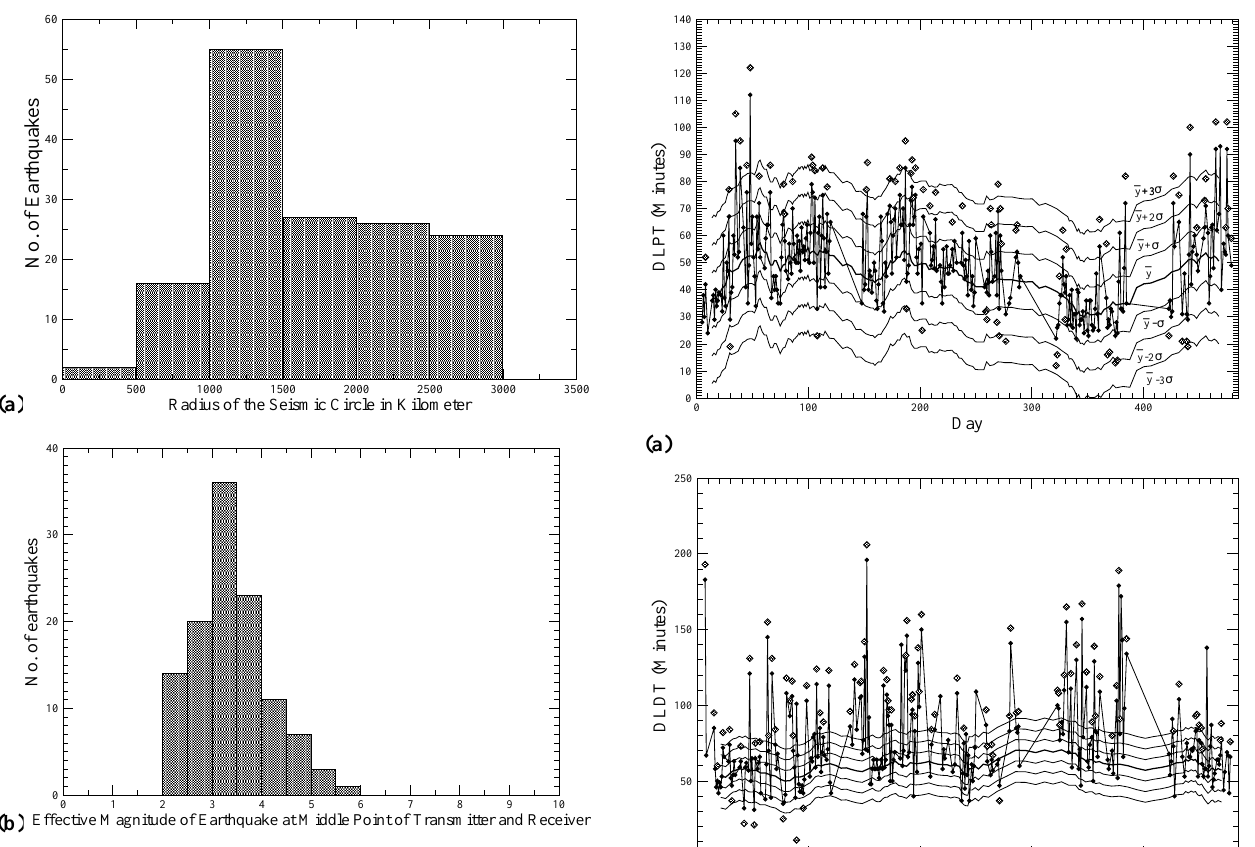
Fig. 2. Histograms of (a) total number of earthquakes in the seismic circles showing that the majority of the earthquakes hap- pened between 1000km and 1500km and (b) the effective mag- nitudes of earthquakes as seen from the FRP. The plot peaks at Fig. 2. (a-b): Histograms of (a) total number of earthquakes in the <M s > ∼ 3 − 3 . 5. seismic circles showing that the majority of the earthquakes hap- Fig. 2. (a-b): Histograms of (a) total number of earthquakes in the pened between 1000 km and 1500 km and (b) the effective mag- seismic circles showing that the majority of the earthquakes hap- nitudes of earthquakes as seen from the FRP. The plot peaks at pened between 1000 km and 1500 km and (b) the effective mag- Fig. 2. (a-b): Histograms of (a) total number of earthquakes in the < M s > ∼ 3 . 5 − 4 . nitudes of earthquakes as seen from the FRP. The plot peaks at seismic circles showing that the majority of the earthquakes hap- < M s > ∼ 3 . 5 − 4 . pened between 1000 km and 1500 km and (b) the effective mag- nitudes of earthquakes as seen from the FRP. The plot peaks at < M s > ∼ 3 . 5 − 4 .